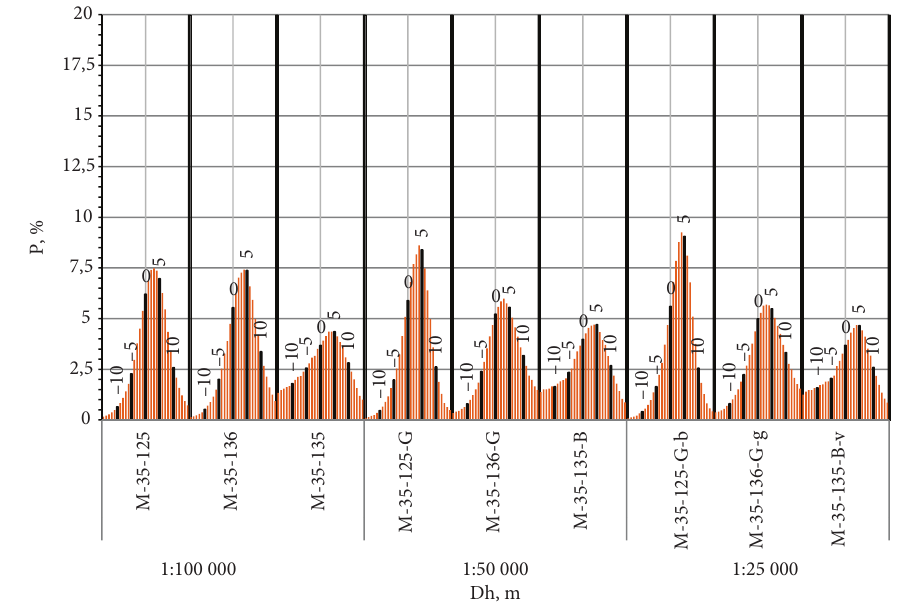
Fig. 6. ASTER GDEM Elevation Error Distribution Histogram for different scales and terrain